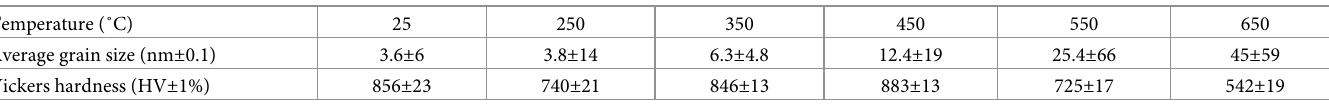
Table 2. The average grain size and Vickers hardness of the deposited and heat-treated